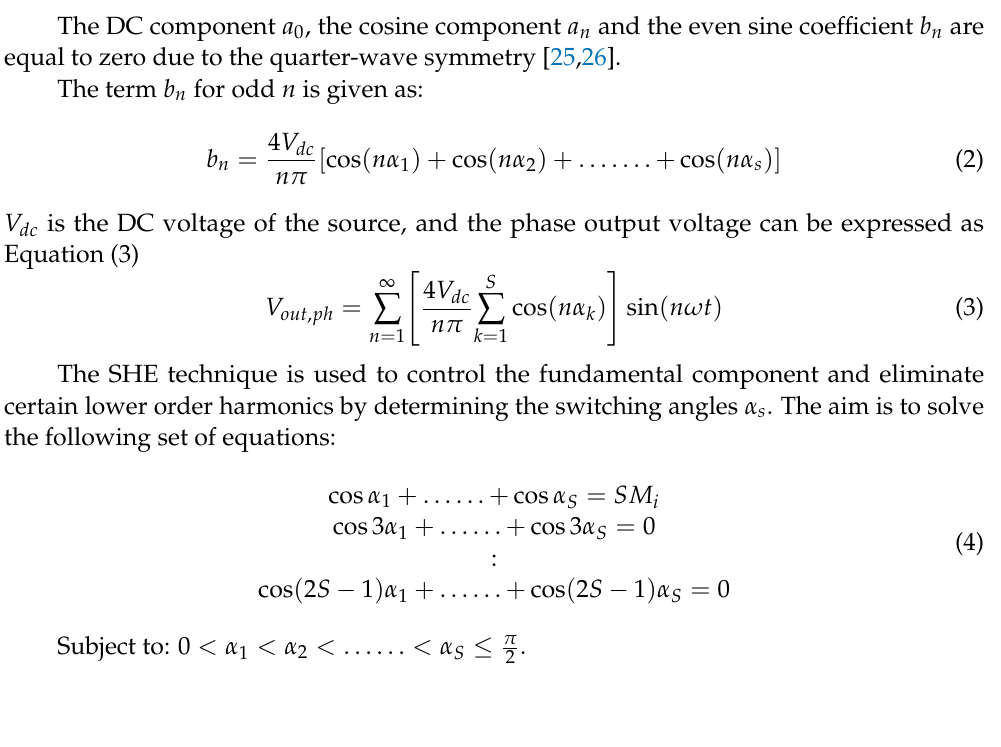
equal to zero due to the quarter-wave symmetry